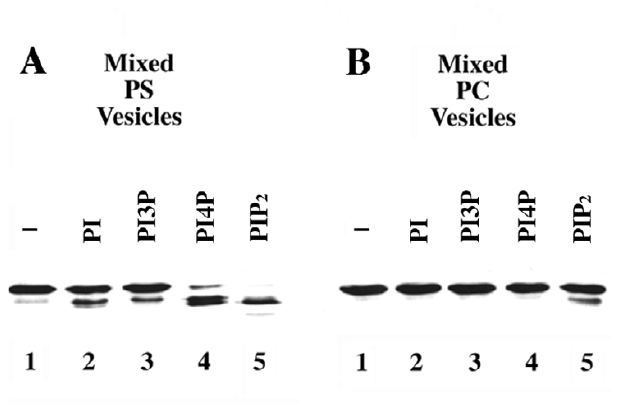
Figure 2 Effects of different phospholipids on the proteolysis of Boi1-PH. Shown are immunoblots, probed with anti- Boi1 antibodies, of aliquots from a Boi1-PH-bearing yeast extract that was incubated, in the presence of 2 mM CaCl 2 (to allow proteolysis), with vesicles containing PS (part A) or PC (part B). The vesicles contained either no additional lipid (lanes 1) or a 1:20 (mass:mass) ratio (with respect to PS or PC) of PI (lanes 2), PI3P (lanes 3), PI4P (lanes 4), or PIP 2 (lanes